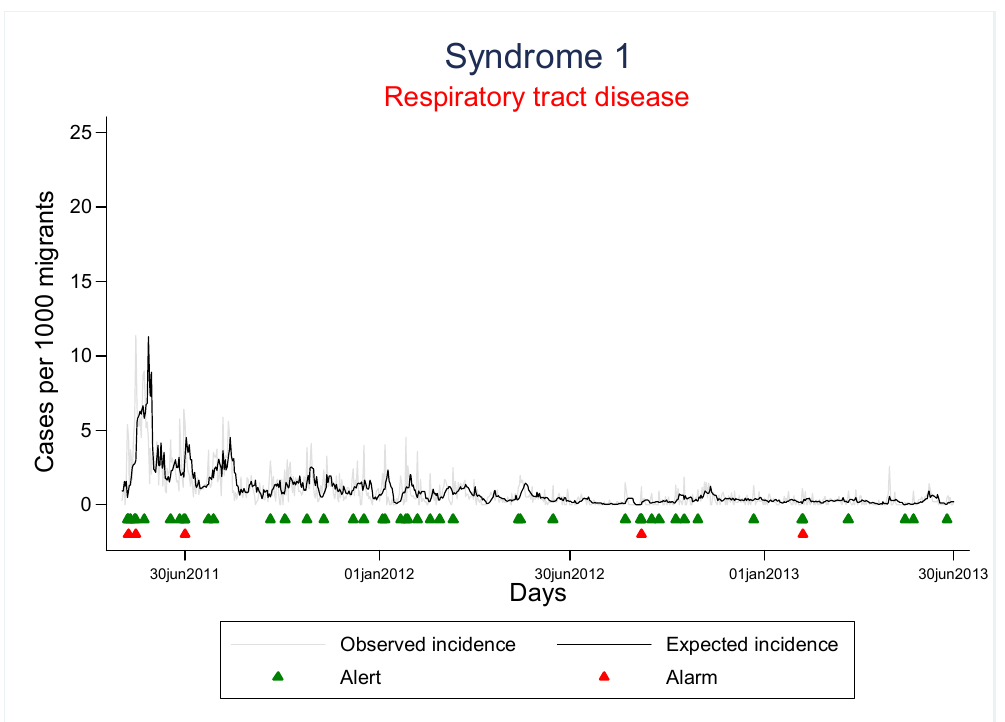
Figure 2. Alerts and alarms triggered by “Respiratory Tract Disease” ( a ), “Watery Diarrhoea” ( b ) and “Parasite Skin Infection” ( c ), 1 May 2011–30 June 2013. Syndrome Respiratory tract disease